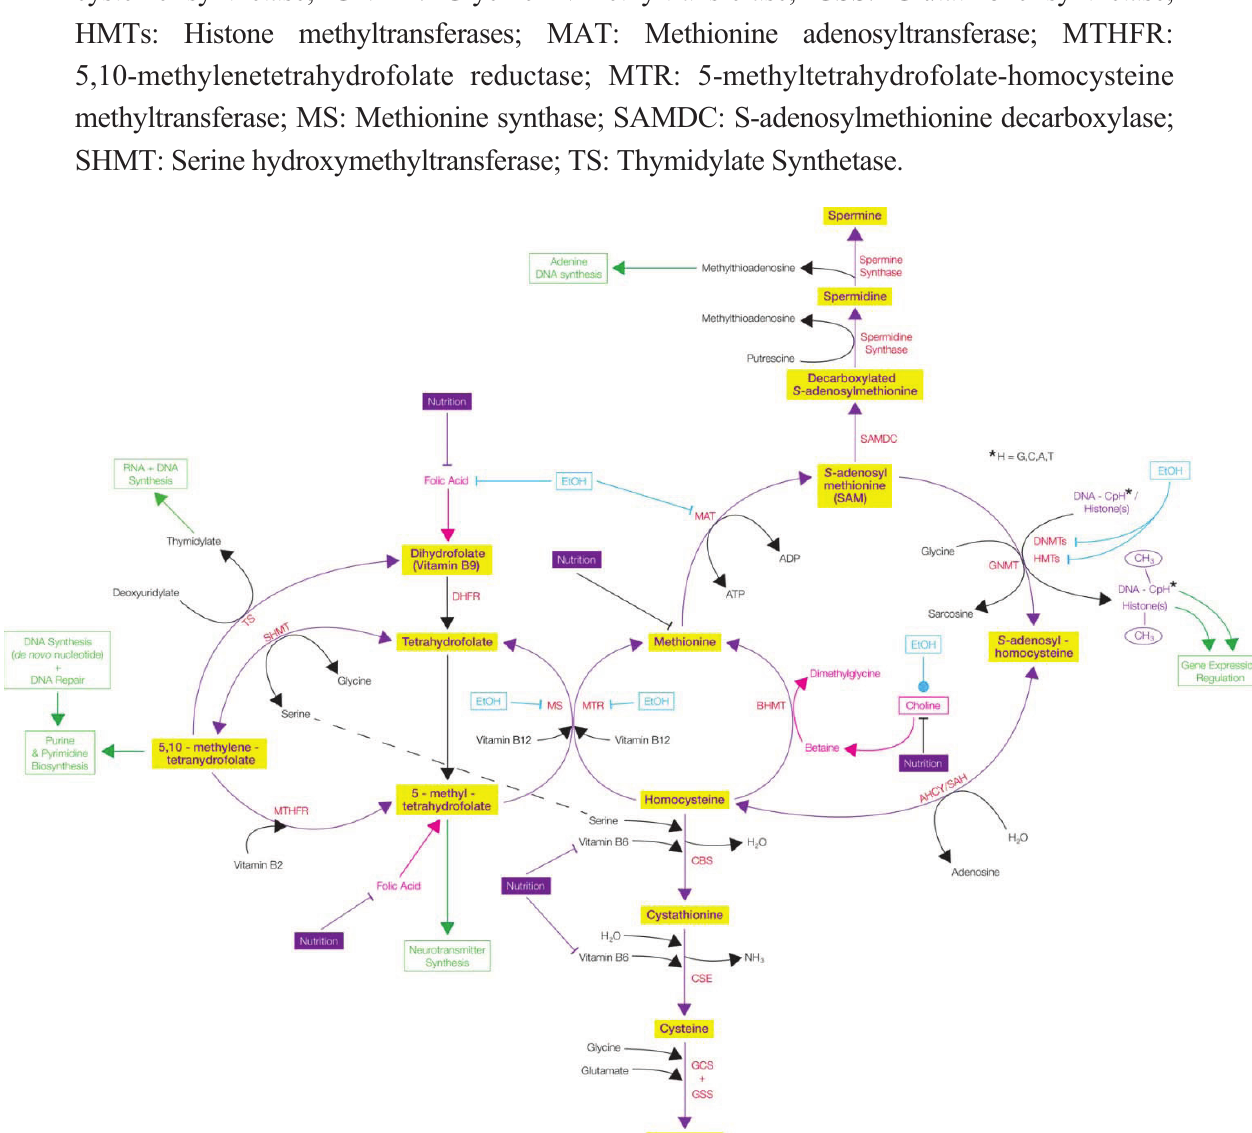
Figure 4. One carbon metabolism and the effects of alcohol (EtOH) and nutrition throughout the metabolical pathway. Ethanol is known to increase histone 3 (H3) acetylation, increase and decrease H3 methylation levels, and alter mitogen-activated protein (MAP) kinases. Ethanol can also have an effect on S -adenosylmethionine (SAM) biosynthesis, which is a methyl donor for DNA methyltransferases (DNMTs) and histone methyltransferases (HMTs), thereby having an effect on DNA methylation (generally hypomethylation). It also plays roles in other metabolic pathways (e.g., polyamine synthesis, transsulfuration, transmethylation, DNA synthesis) [165]. Overall, the biochemical cycle is complex and involves many metabolites and compounds. Green boxes and arrows demonstrate the resulting cellular